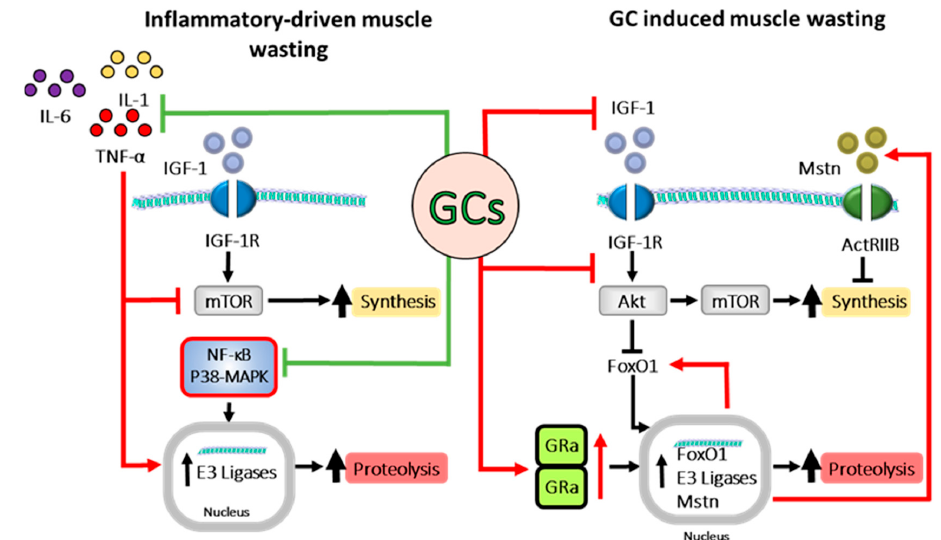
Figure 3. Schematic representation of signalling pathways involved in both inflammatory driven and GC induced muscle wasting and their interactions. Inflammatory cytokines such as TNF- α and IL-1 inhibit mammalian target of rapamycin (mTOR) signalling, dampening muscle protein synthesis, whilst simultaneously inducing transcription of E3 ligases, leading to muscle